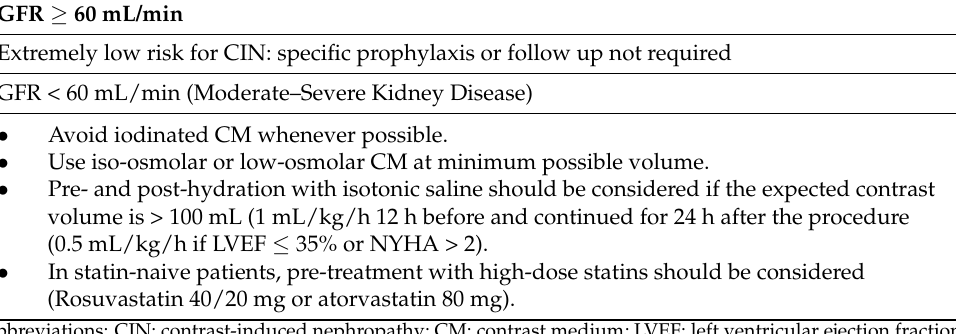
Table 3. Prevention of contrast-induced nephropathy.